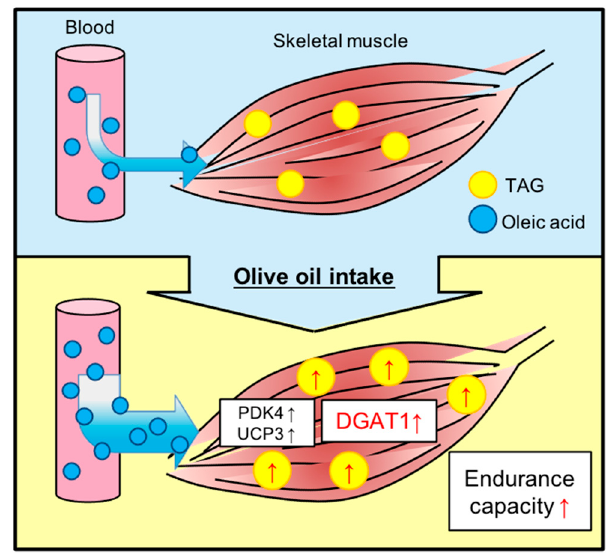
Figure 5. Graphical abstract. Olive oil improves endurance capacity with increased IMTG pools via upregulation of DGAT1. The upward arrow ( ↑ ): upregulation of factors, increase of IMTG content, or improvement of endurance capacity.